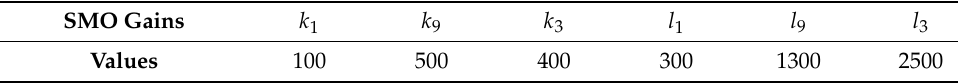
Table 2. Sliding Mode Observer